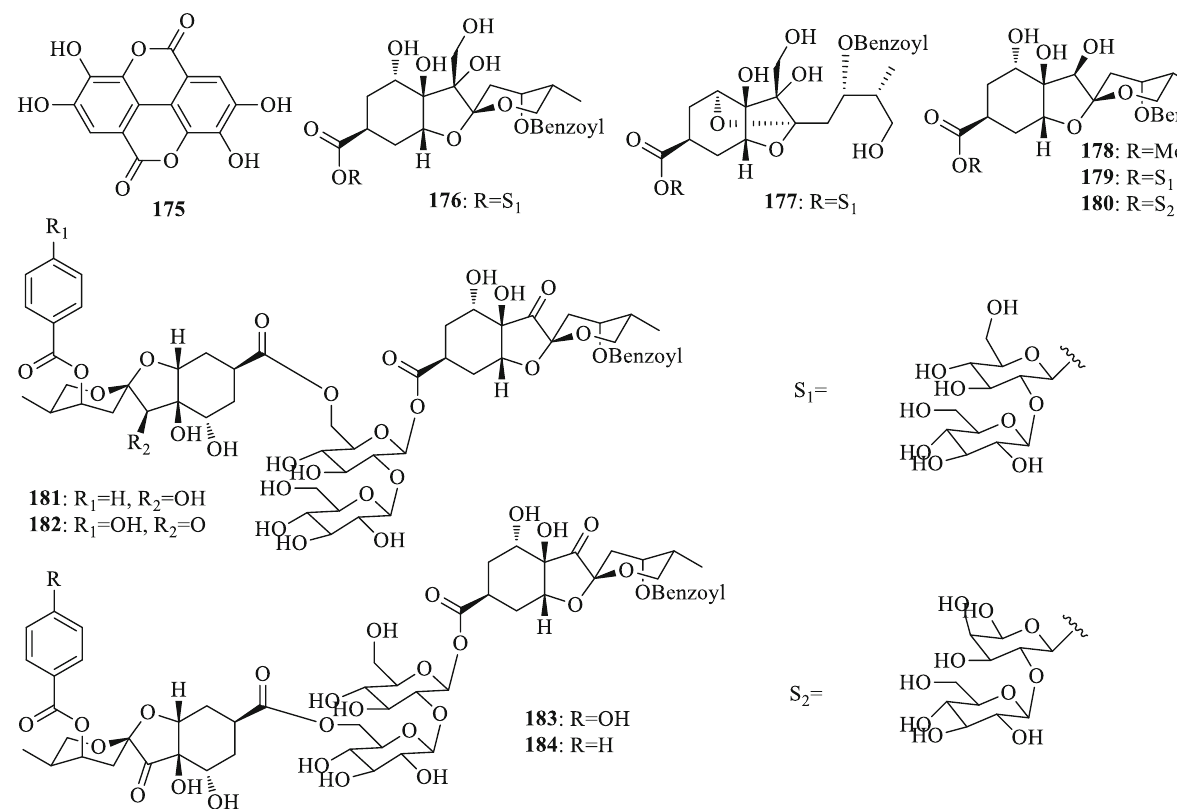
Fig. 12 Structures of compounds 175 –